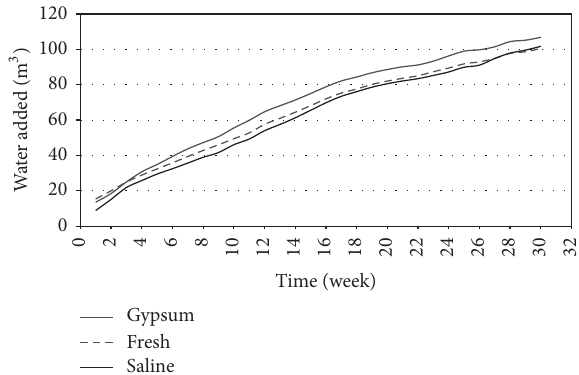
Figure 2: Cumulative water quantities (m 3 ) added during the leaching process (gypsum amended soil, fresh water, and saline